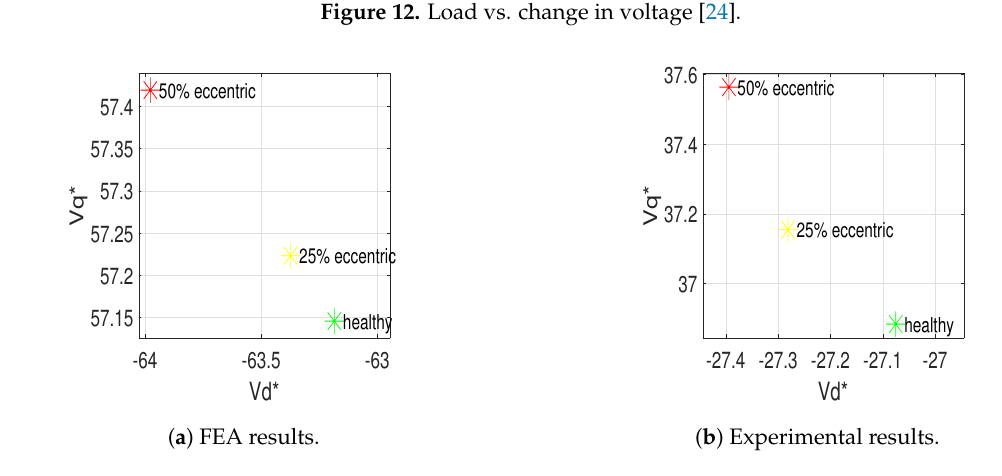
Figure 13. Shift in V d / V q with eccentricity